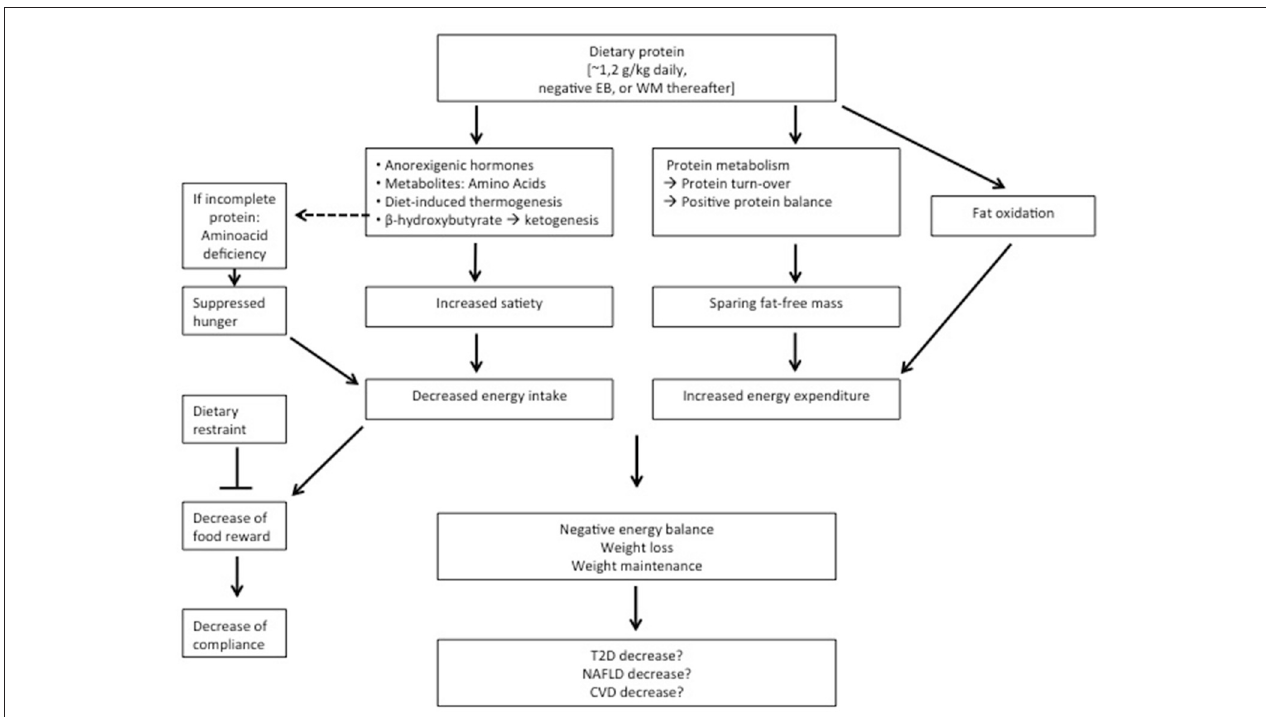
FIGURE 1 | Summary of the observations on relatively high protein diets applied during energy restriction or weight maintenance (WM) thereafter. EB, energy balance; T2D, type 2 Diabetes; NAFLD, non-alcoholic fatty liver disease; CV, cardiovascular diseases.